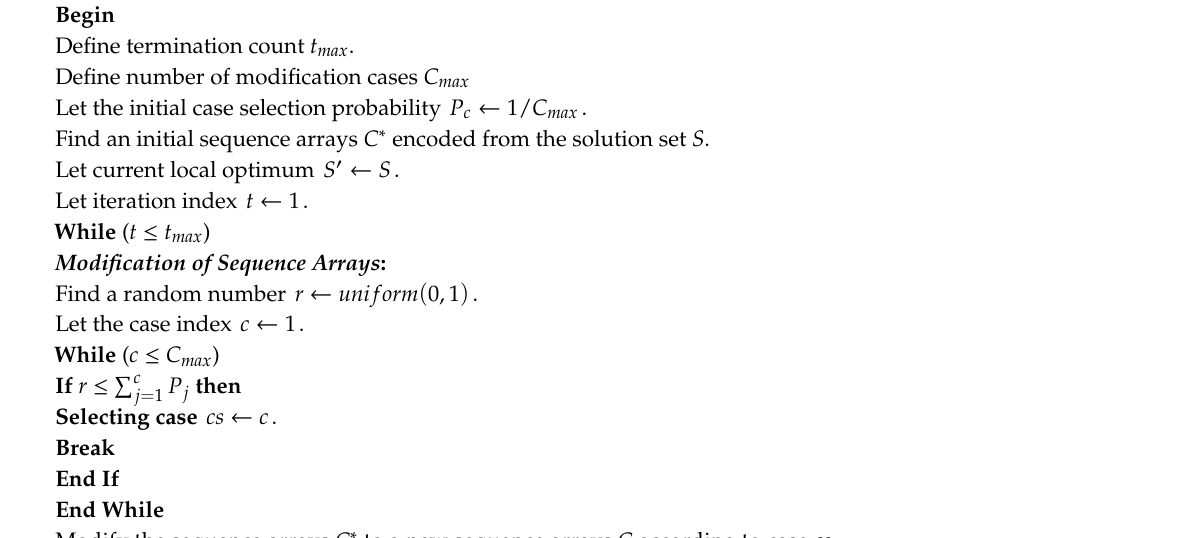
Algorithm 2. Local search with static case selection